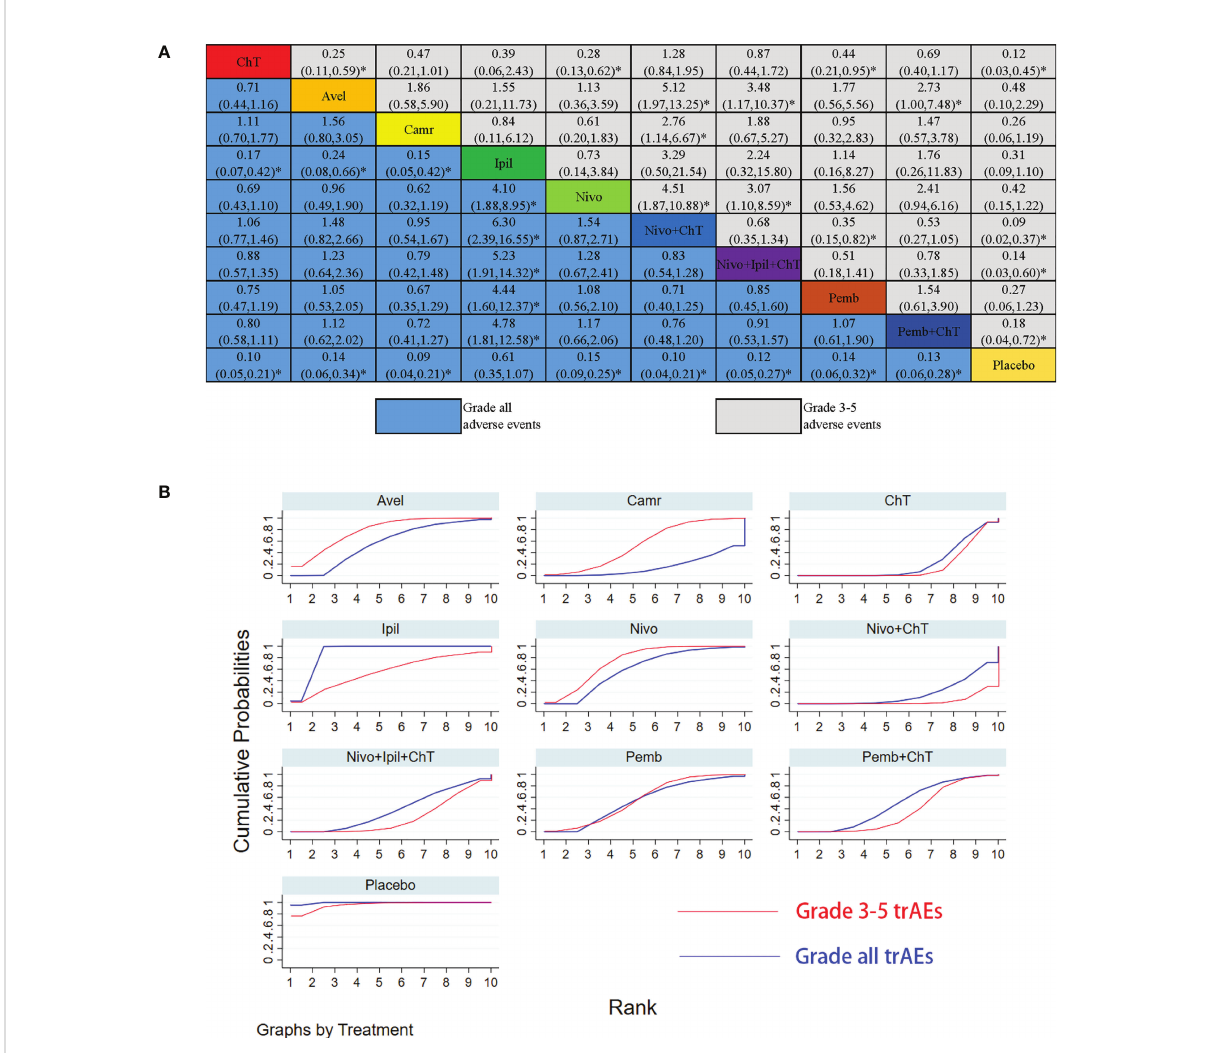
FIGURE 4 Results of the network meta-analysis for 10 treatment regimens in terms of treatment-related adverse events(trAEs) with grade 3 – 5 trAEs and all-grade trAEs. (A) League table for different treatment regimens. Relative effects (RRs) with 95% con fi dence intervals are shown for different treatment regimens compared with each other. The RR for a given comparison could be read in the intersection of two treatments. All Z -tests to compare two treatments were performed two-sided. * P < 0.05. ChT, chemotherapy; Avel, avelumab; Camr, camrelizumab; Ipil, ipilimumab; Nivo, nivolumab; Pemb, pembrolizumab. Placebo also involves the best supportive care. (B) The surface under the cumulative ranking curves (SUCRAs) for grade 3 – 5 trAEs and all-grade